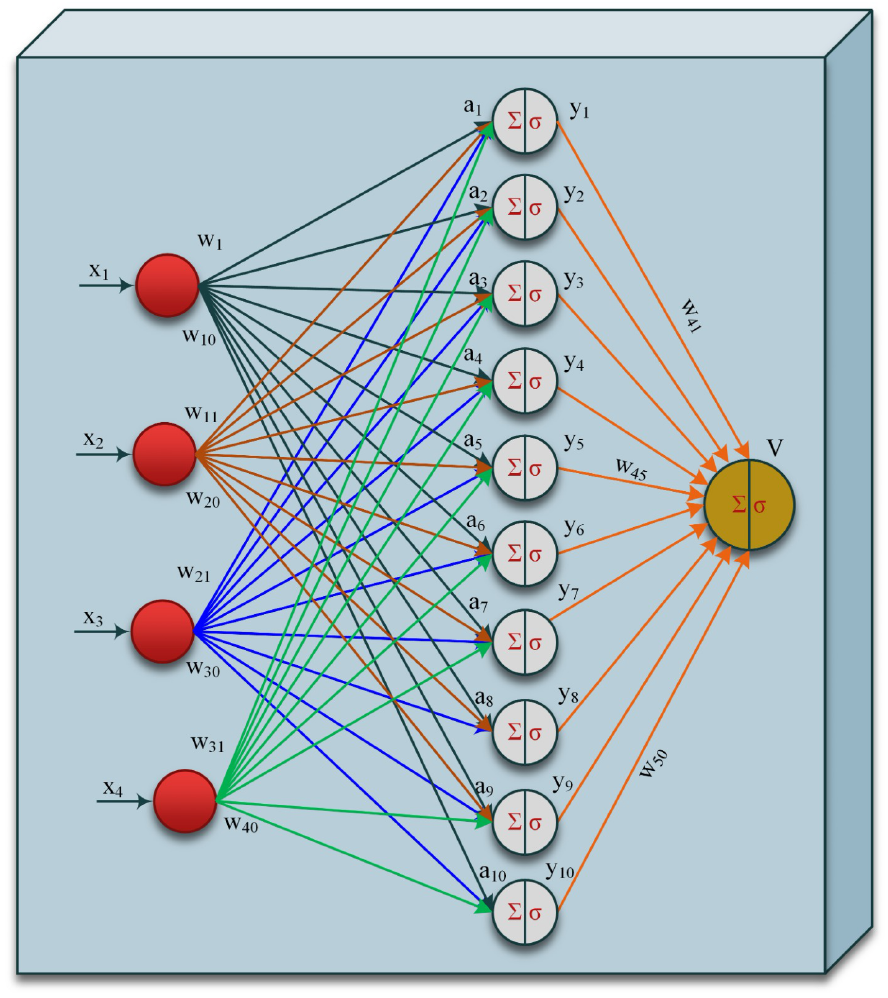
Figure 4. QEN internal